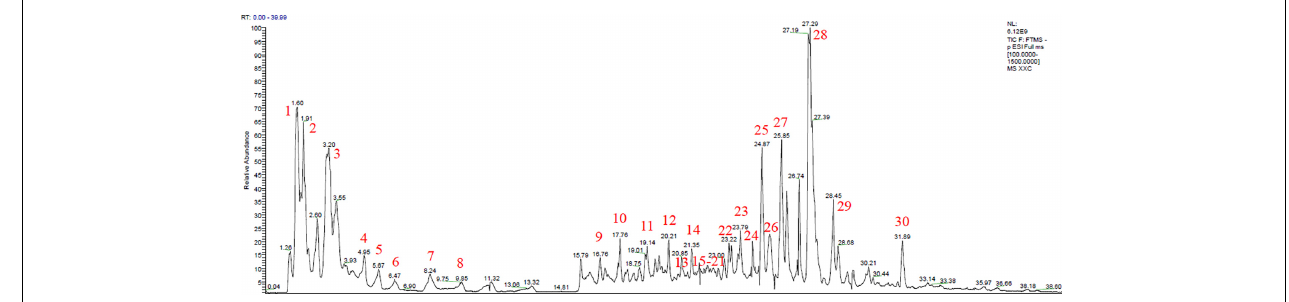
FIGURE 1 | Total ion chromatogram (TIC) scan of Herba Siegesbeckiae (HS) in negative mode.